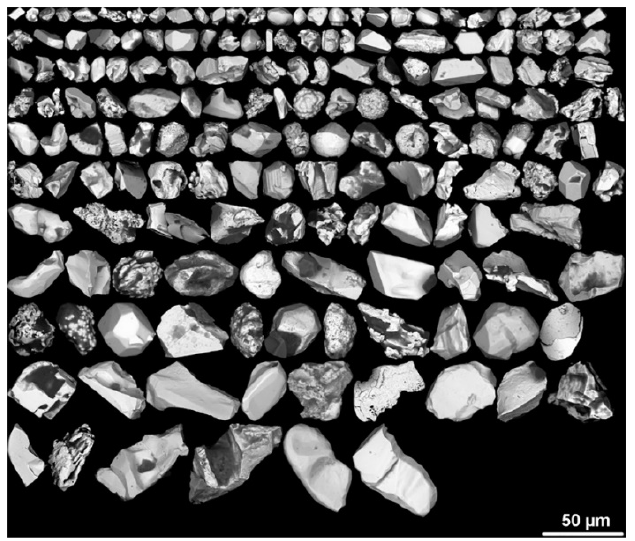
Figure 2. A mosaic of 166 precious metals minerals (PMM) excluding Au is automatically generated by the routine. These PMM include various species of platinum-group elements-bearing and Ag-bearing minerals found in till samples collected in the Nunavik area (Quebec, Canada).